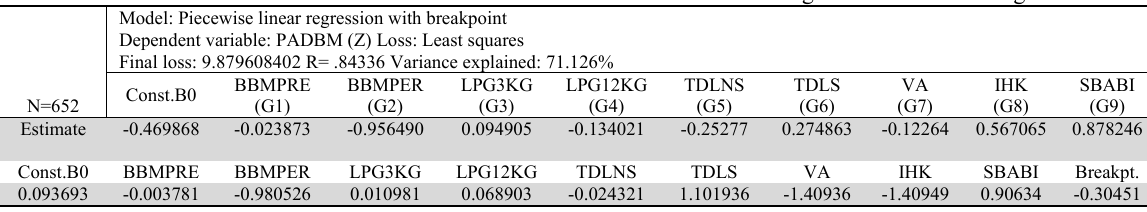
The result of nine disturbance variables effect on economic resilience variable Z using Piecewise Linear Regression Model: Piecewise linear regression with breakpoint Dependent variable: PADBM (Z) Loss: Least squares N=652